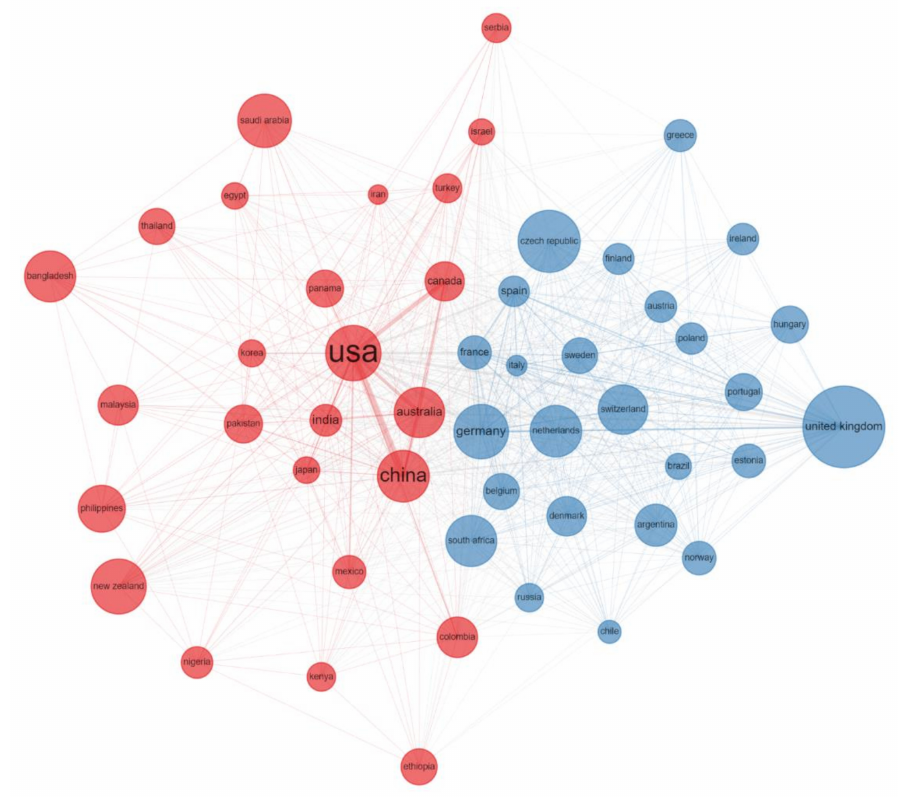
Figure 4. Country collaboration